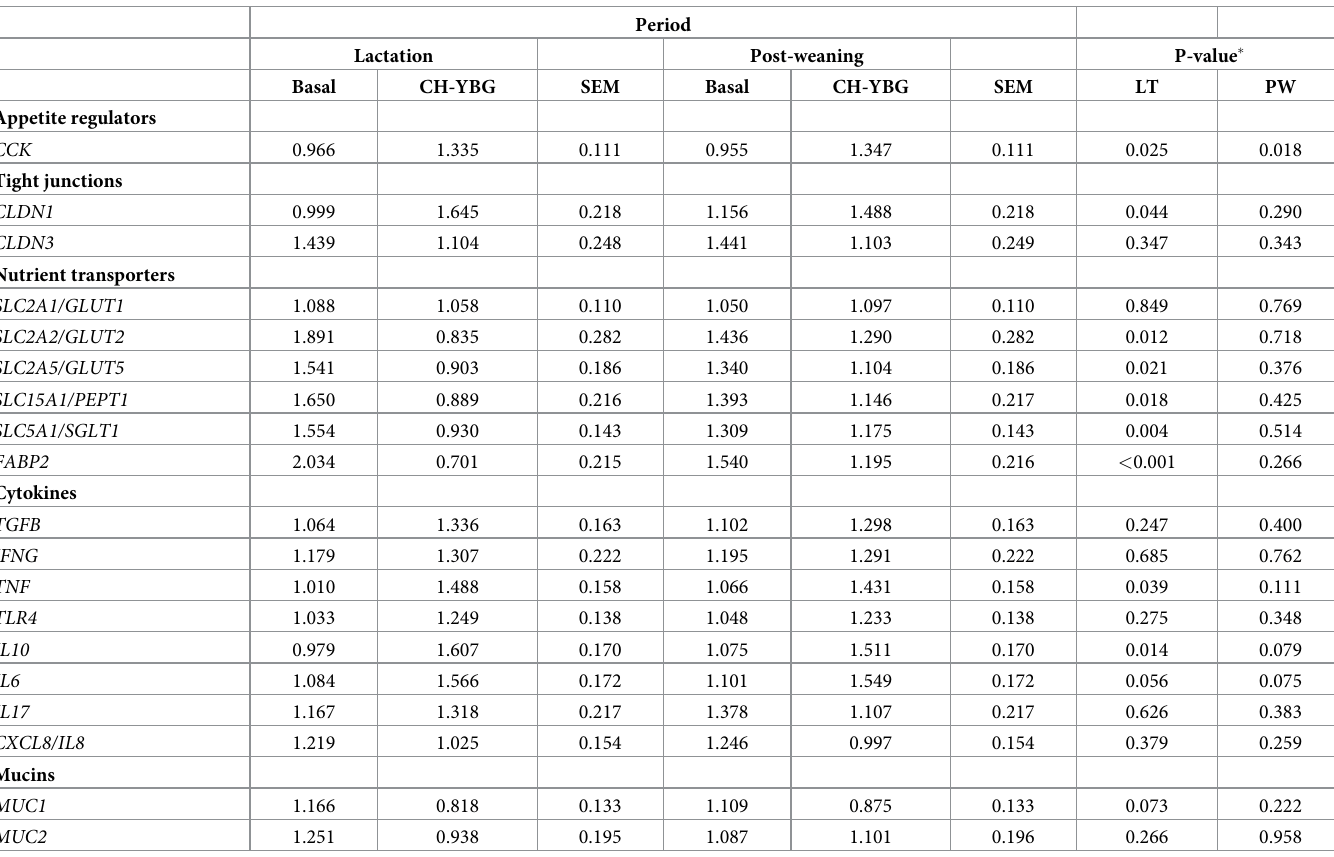
Table 13. Effect of supplementation of CH-YBG during gestation/lactation and/or post-weaning on the expression appetite regulators, tight junctions, nutrient transporters, cytokines and mucins in the ileum. (least-square mean values with their standard error of means).